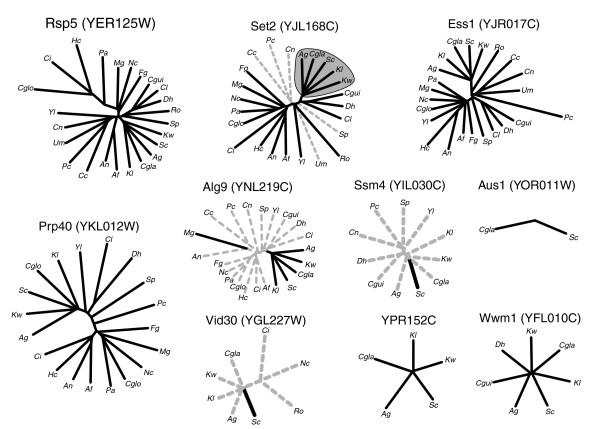
Phylogenetic conservation of WW domains among yeast lineages. Radial trees were generated based upon multiple alignments for orthologs culled from 24 yeast species. Solid lines indicate lineages in which the WW domain is maintained in the orthologous proteins, whereas dashed lines indicate those proteins in which the WW domain is not present. In the Set2 ortholog group, the WW domains highlighted in gray are most similar to the meta-WW domain in S. cerevisiae, whereas in the other lineages the WW domain conforms to the group II/III classification. Organism abbreviations are Saccharomyces cerevisiae (Sc),Candida guilliermondii (Cgui),Candida glabrata (Cgla),Chaetomium globosum (Cglo),Kluyveromyces waltii (Kw),Kluyveromyces lactis (Kl),Yarrowia lipolytica (Yl),Candida lusitaniae (Cl),Debaryomyces hansenii (Dh),Schizosaccharomyces pombe (Sp),Pneumocystis carinii (Pc),Fusarium graminearum (Fg),Magnaporthe grisea (Mg),Neurospora crassa (Nc),Podospora anserina (Pa),Aspergillus fumigatus (Af),Aspergillus nidulans (An),Ashbya gosypii (Ag),Histoplasma capsulatum (Hc),Coccidioides immitis (Ci), Ustilago maydis (Um),Cryptococcus neoformans (Cn),Coprinus cinereus (Cc),and Rhizopus oryzae (Ro).